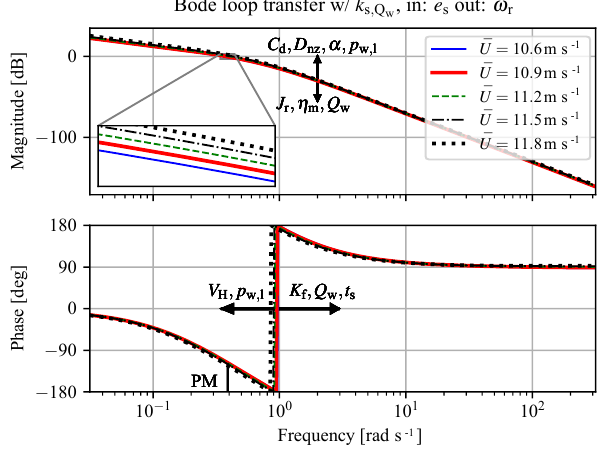
Figure 18. Bode plot of the plant for transfer from spear valve posi- tion reference to the rotor speed, with spear valve pressure feedback gain k s ,Q . The effect of increasing important model parameters on w the frequency response is indicated, together with the phase margin (PM) at the magnitude crossover frequency.